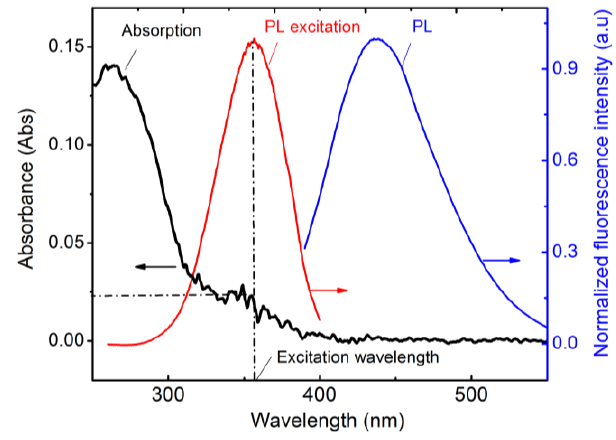
Fig. 3. Absorption, Excitation (PL excitation) and Photoluminescence (PL) spectra of the Si/SiO 2 spheres containing solution.